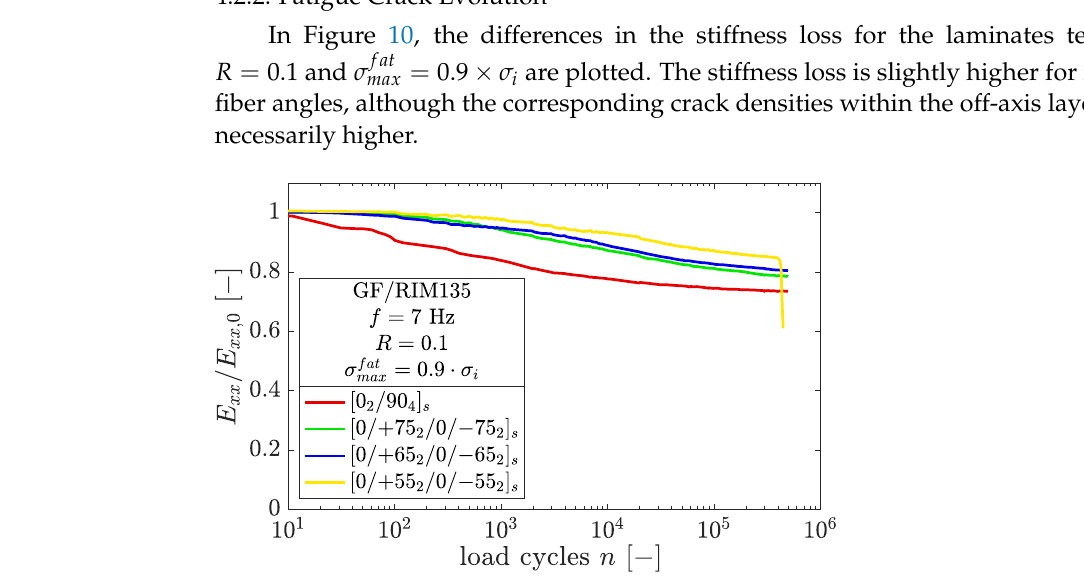
Figure 10. Stiffness loss for the tested laminates at R = 0.1 and the highest load level, σ fat max = 0.9 × σ i